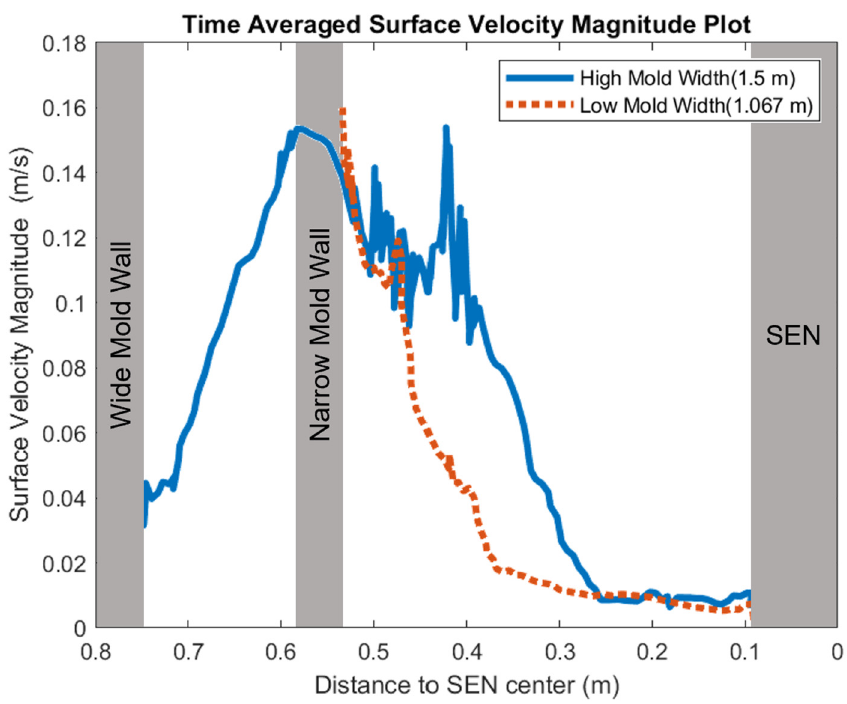
Figure 20. Low mold width (Case 5) vs. high mold width (Case 7) surface velocity comparison.